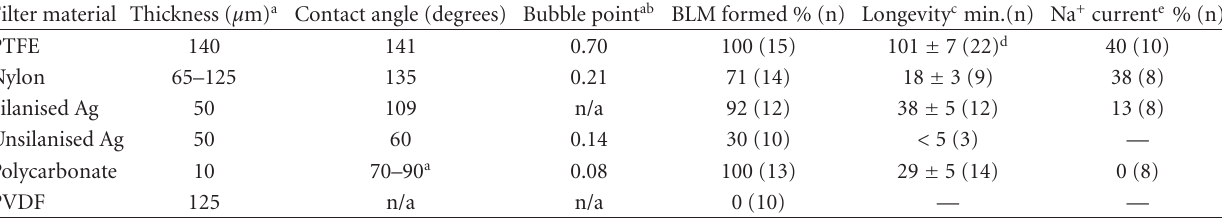
a Data from manufacturer in methods. b Alcohol bubble point (kg.cm − 2 ). c Mean ± S.E.M. d PTFE monitored for up to 2h, 73% lasted > 2h. e